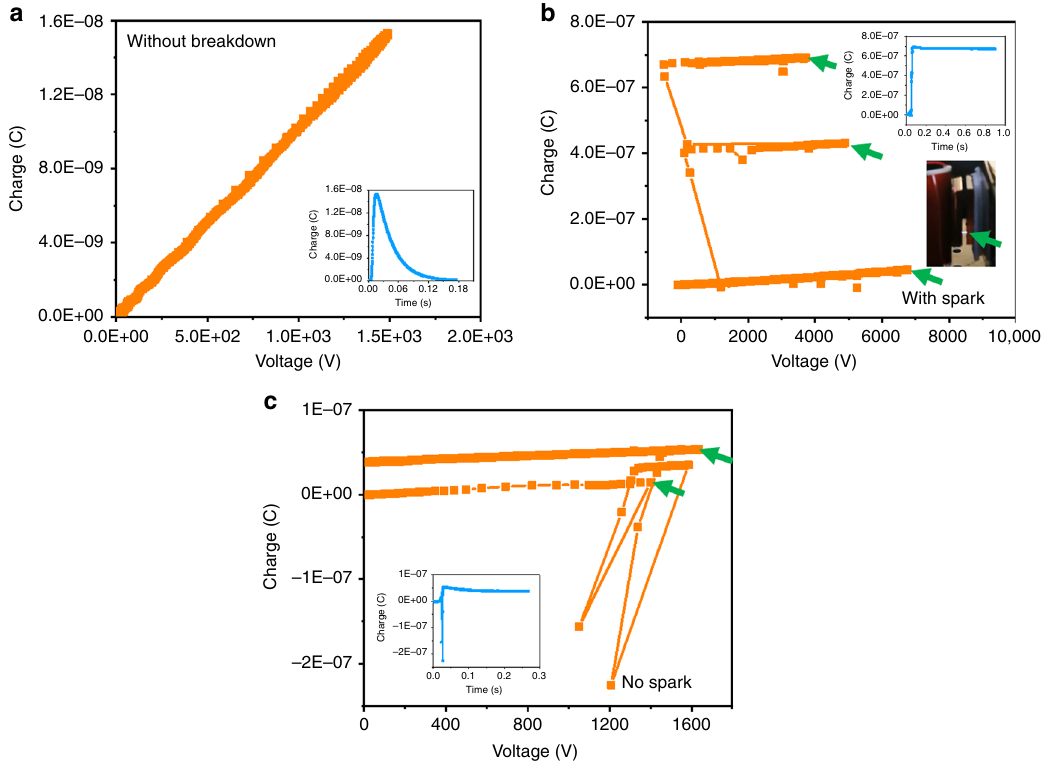
Fig. 2 Output characteristics of breakdown. Q – V plots of CS mode TENG for a no breakdown; b breakdown with spark; c breakdown without spark. Inset plots with lines in blue in a – c are the transfer charge results. Target points by green arrows in b and c are breakdown points. The inset picture of b is the photo of a visible spark at x = 2 mm. Source data are provided as a Source Data fi